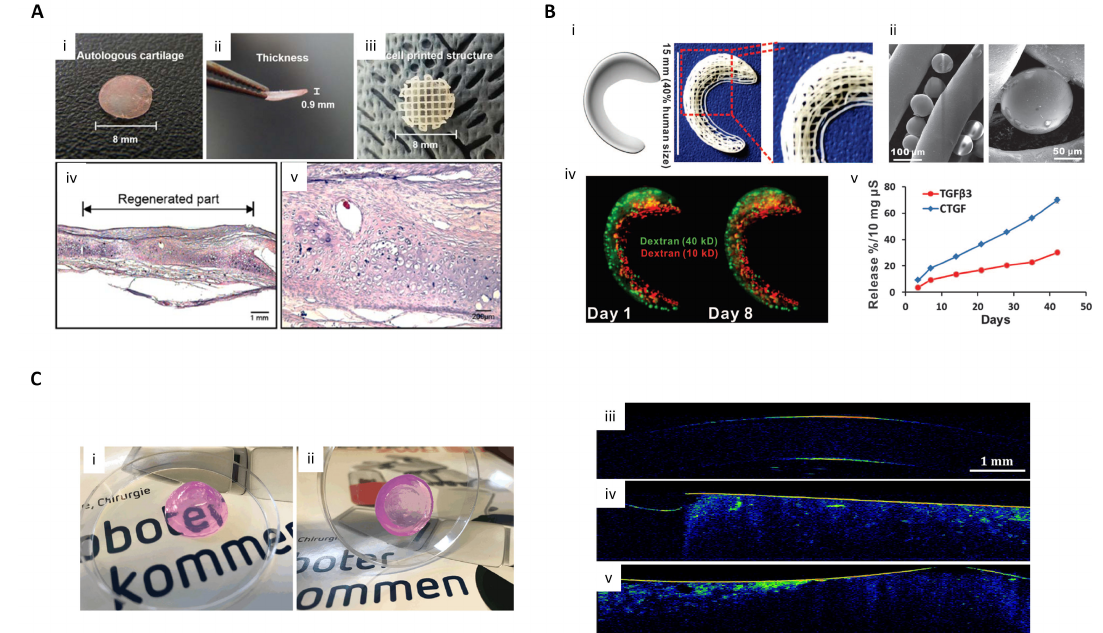
Figure 2. Therapeutic applications of 3D printing for cartilage and cornea regeneration. ( A ) 3D cell printed structure for cartilage defect treatment. (i,ii) Autologous cartilage; (iii) Cell-printed structure; (iv,v) HE staining result of in vivo cell-printed structure implantation (reproduced with permission from ref [144]; copyright 2017 Wiley-VCH). ( B ) Sca ff old spatiotemporally releasing growth factor for meniscus defect treatment. (i) Anatomic reconstruction of a human meniscus and 3D-printed meniscus sca ff old; (ii) PLGA microspheres encapsulating growth factors with PCL microfibers; (iii) Maintenance of fluorescent dextrans in meniscus sca ff old from Day 1 to Day 8; (iv) growth factor release profile from the sca ff old over time (reproduced with permission from ref [147]; copyright 2014 American Association for the Advancement Science). ( C ) 3D structure of bioprinted models with human corneal stromal keratocytes and their optical properties. (i,ii) Transparent bioprinted dome-shaped artificial corneas consisting of 0.5% agarose and 0.2% collagen Type I. (iii—v) Optical coherence tomography images of native rabbit corneas; (iii) Cell-free blend of 0.5% agarose with 0.2% collagen Type I; (iv) Corneal